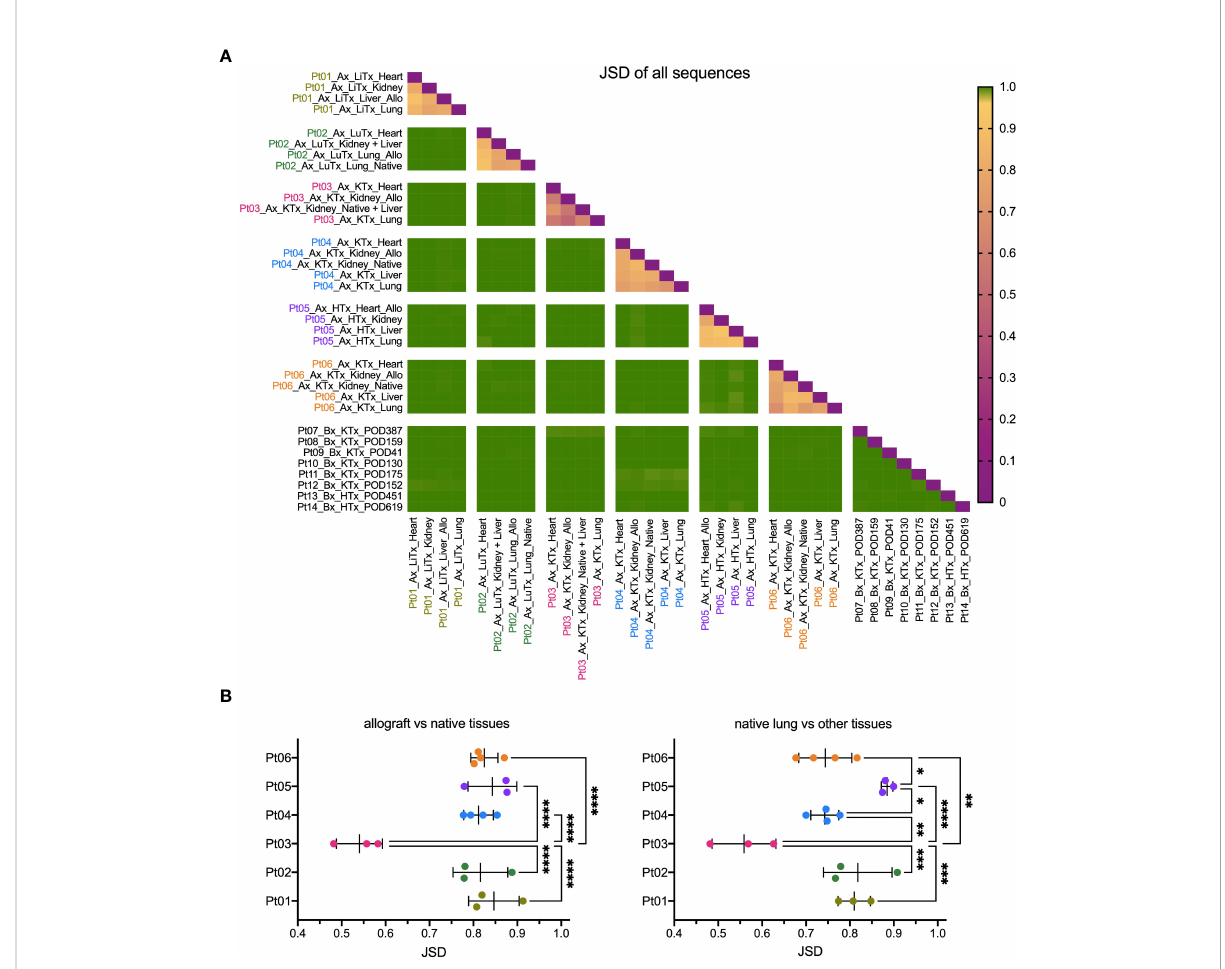
FIGURE 2 Similarity of TCR clonal distribution across individual patients and tissue types. (A) Jensen-Shannon divergence (JSD) quantitatively compares TCR repertoire overlap and similarity between two populations, taking into account clone frequency. JSD=1 indicates totally divergent repertoires and JSD=0 indicates identical repertoires. JSD data of all patients and tissue types were pooled in heatmap. Ax: autopsy. Bx: biopsy. LiTx: liver transplantation. LuTx: lung transplantation. KTx: kidney transplantation. HTx: heart transplantation. Allo: allograft. (B) JSD values between allograft vs native tissues (left panel) and between native lung vs other tissues (right panel) within each patient were pooled. One-way ANOVA, followed by Tukey ’ s multiple comparisons test was applied to determine statistical signi fi cance (*p<0.05, **p<0.01, ***p<0.001,